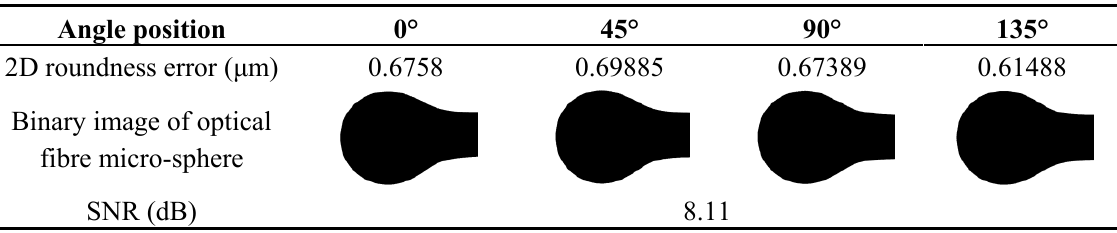
Table 3. Result of 2D roundness error in the condition of optimum combination.